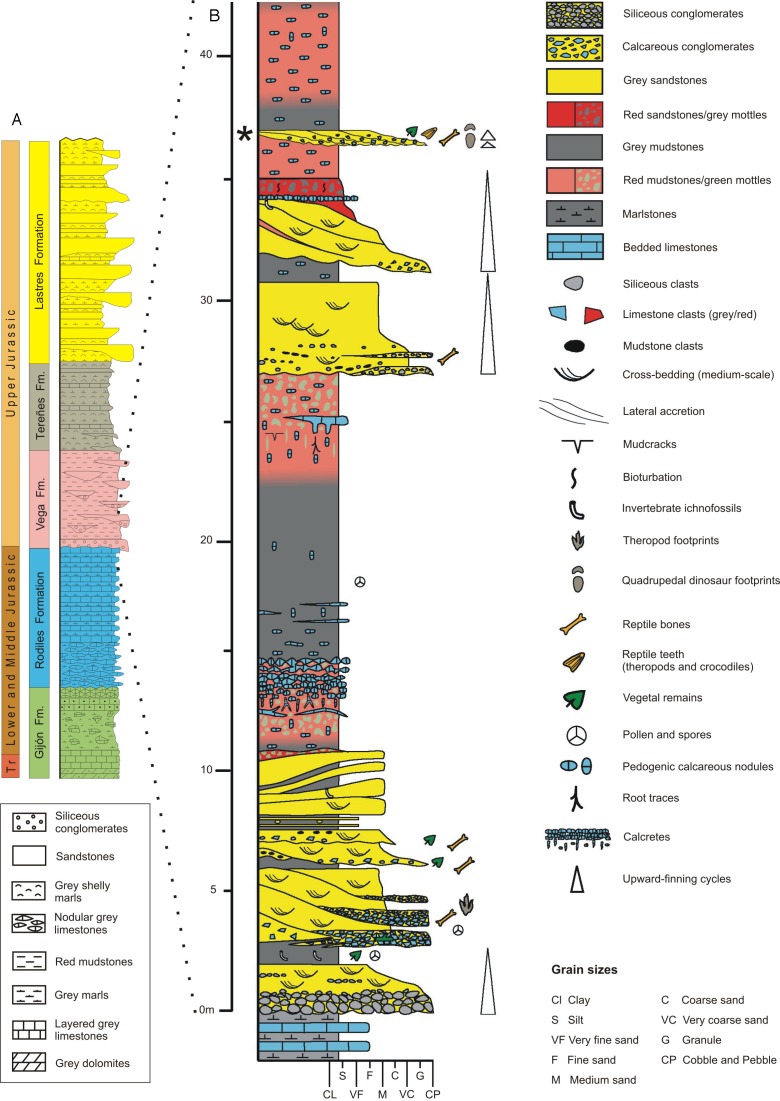
Geology of the Asturian Jurassic.(A) General stratigraphic log of the Asturian Jurassic along the Tazones-Ribadesella sector. Not to scale. Modified after García-Ramos, Piñuela & Rodríguez-Tovar (2011). (B) Detailed log of the lower part of the Vega Formation (after García-Ramos, Aramburu & Piñuela, 2010c). The level where the vertebra was found is indicated by an asterisk.